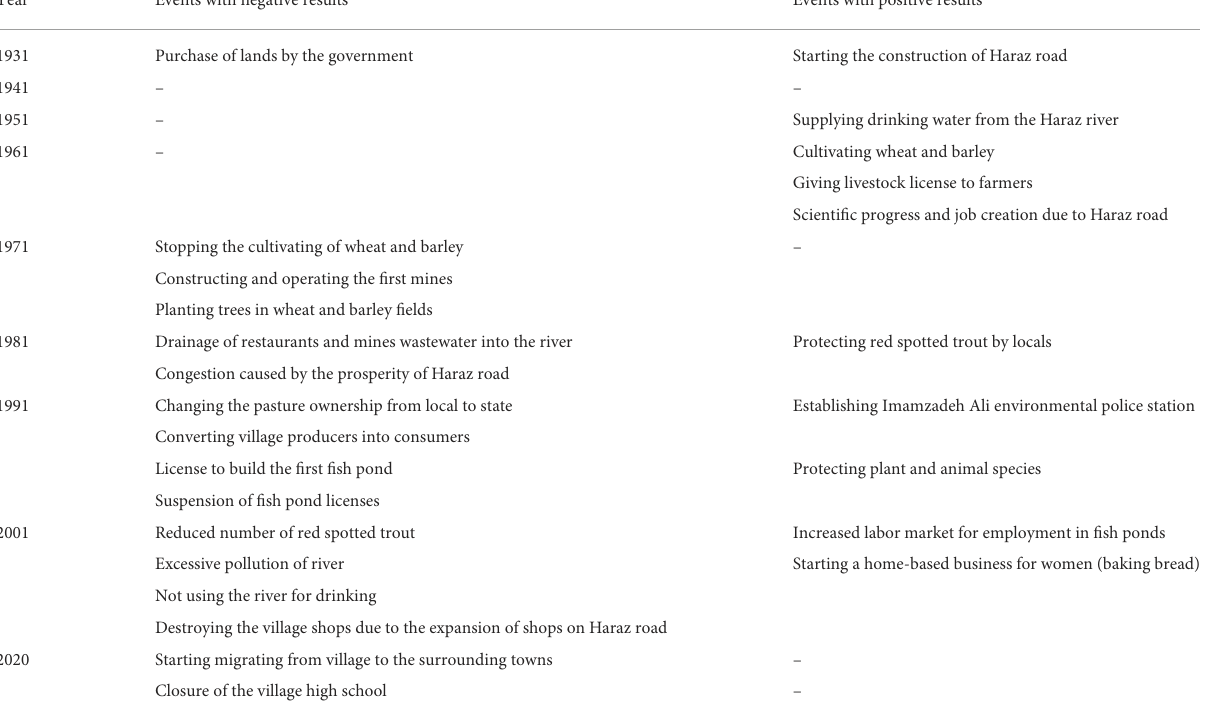
TABLE 2 Results of the historical trend technique in Ab Ask